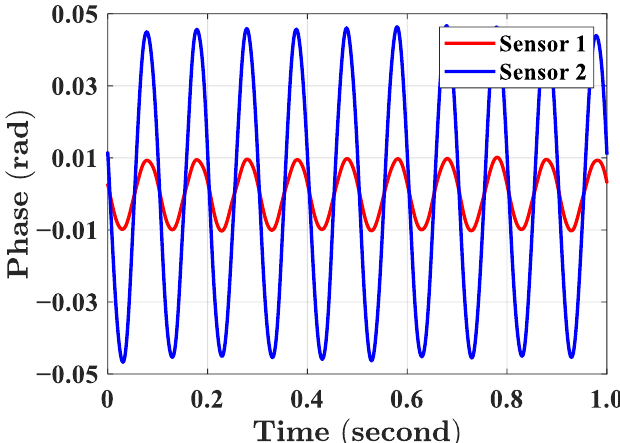
Figure 7. The sinusoidal magnetic field signals collected by two optical fiber magnetic field sensors.